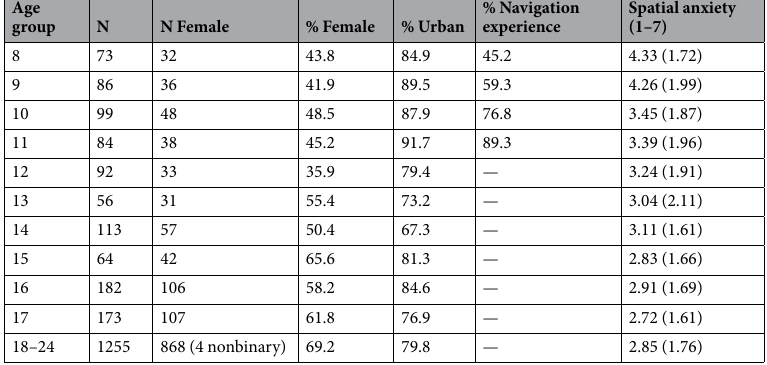
Table 1. Descriptive statistics of participants (age 8–17).